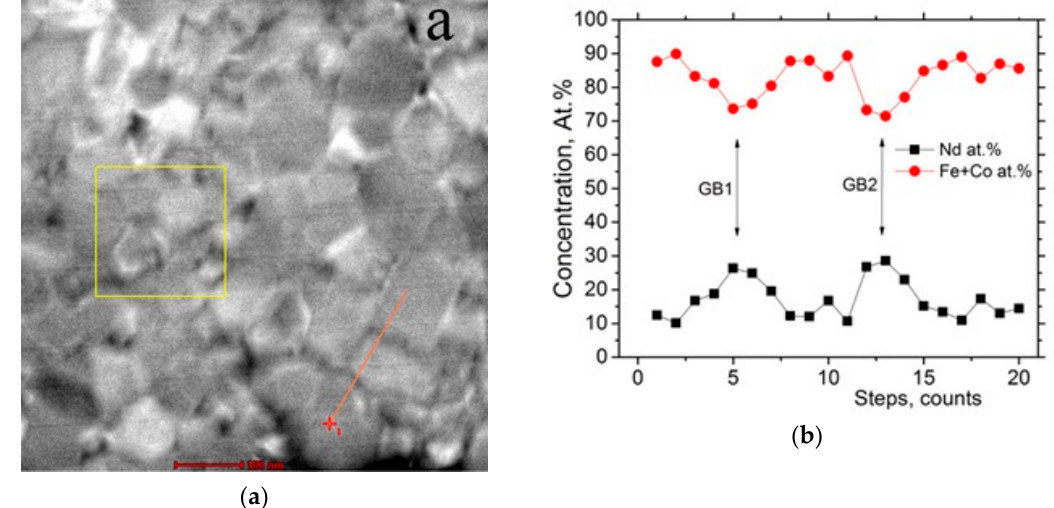
Figure 5. Bright field image ( a ) and result of chemical composition along the red line ( b ) of the SG1 sample after annealing at 625 °C for 30 min.